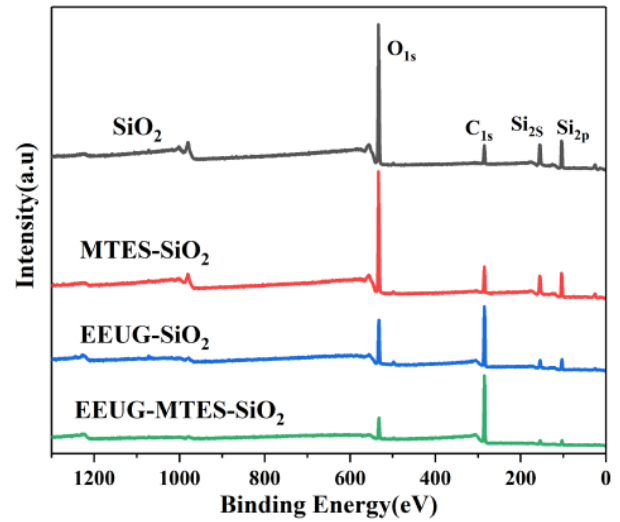
Figure 3. XPS wide-scan spectra of SiO 2 , MTES-SiO 2 , EEUG-SiO 2 , and EEUG-MTES-SiO 2. Table 2. Comparison of atomic content (at.%) in the XPS spectra of SiO 2 , MTES-SiO 2 , EEUG-SiO 2 , and EEUG-MTES-SiO 2 .